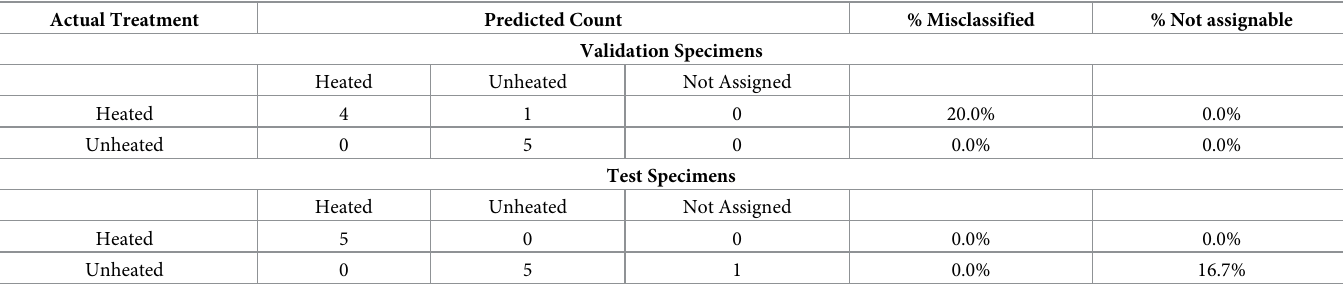
Table 11. k-NN model C specimen-level prediction results.